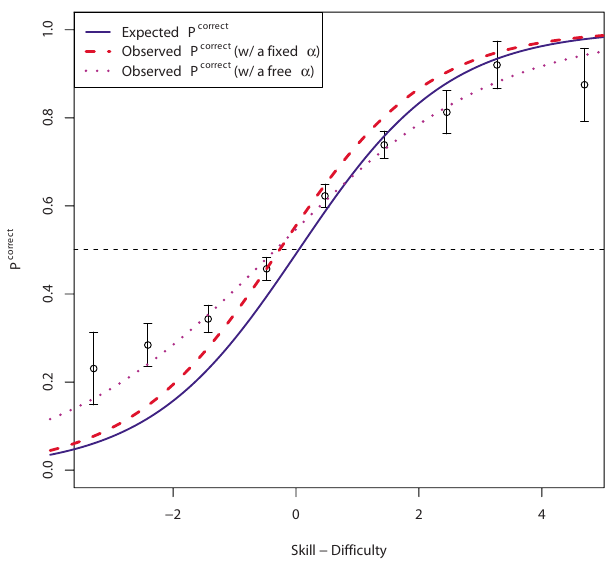
FIG. 3. (cid:1) Color (cid:2) Logistic fits to the second attempt of students after they received useful feedback from the tutor. The discrimina- tion has decreased from 0.82 to